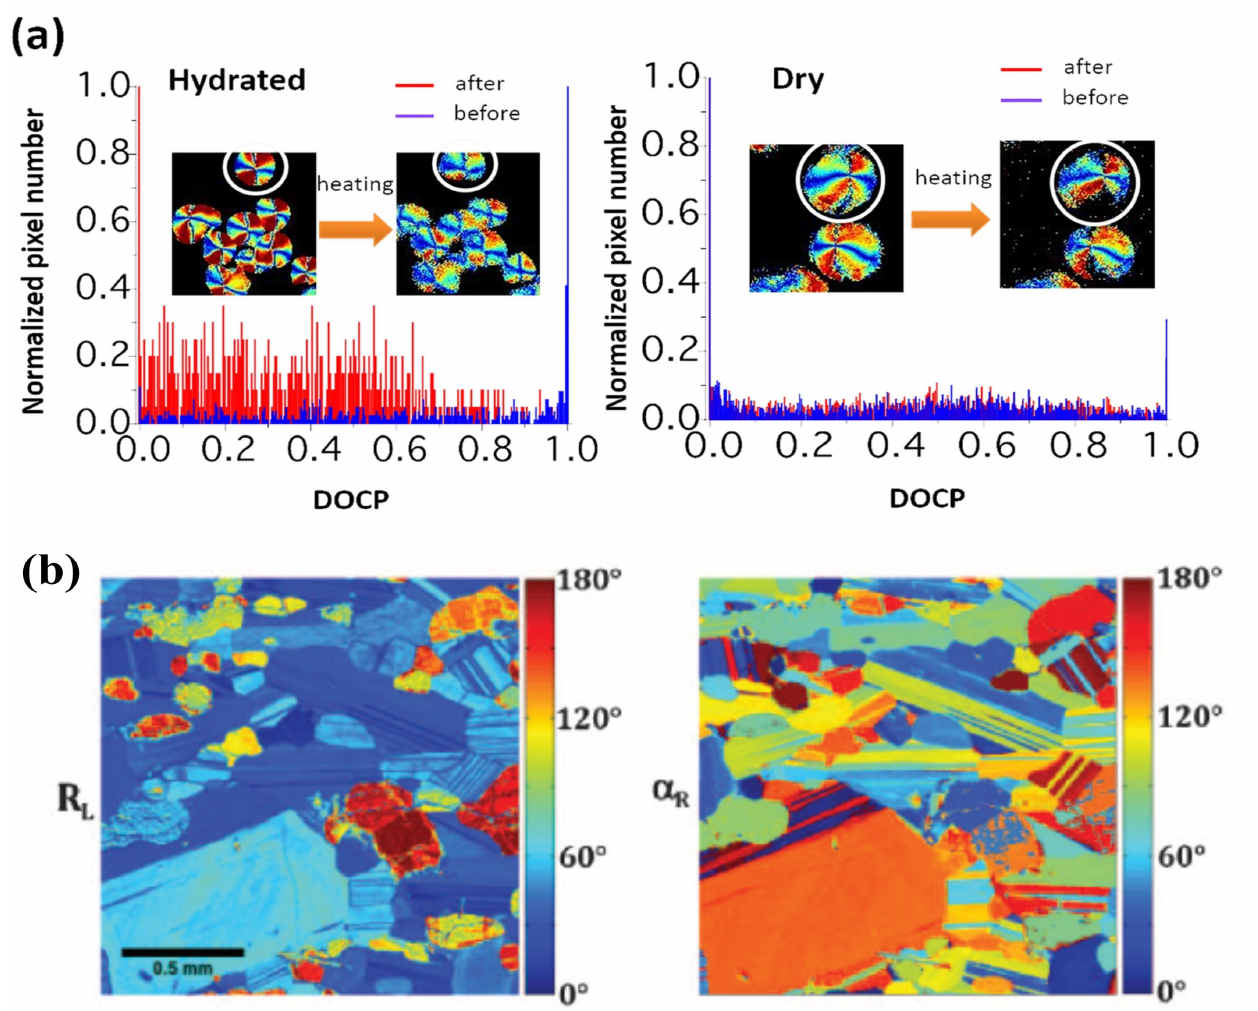
Figure 7. Quantitative MM images taken from material science applications. ( a ) Comparative study of the SHG images of hydrated and dry starch granules after heating. ( b ) Linear retardance RL, and its orientation α R of a gabbro rock section. Adapted with permission from: ( a ) [50], Scientific Reports, under a Creative Commons license (http://creativecommons.org/licenses/by/4.0); ( b ) [31], © The Optical